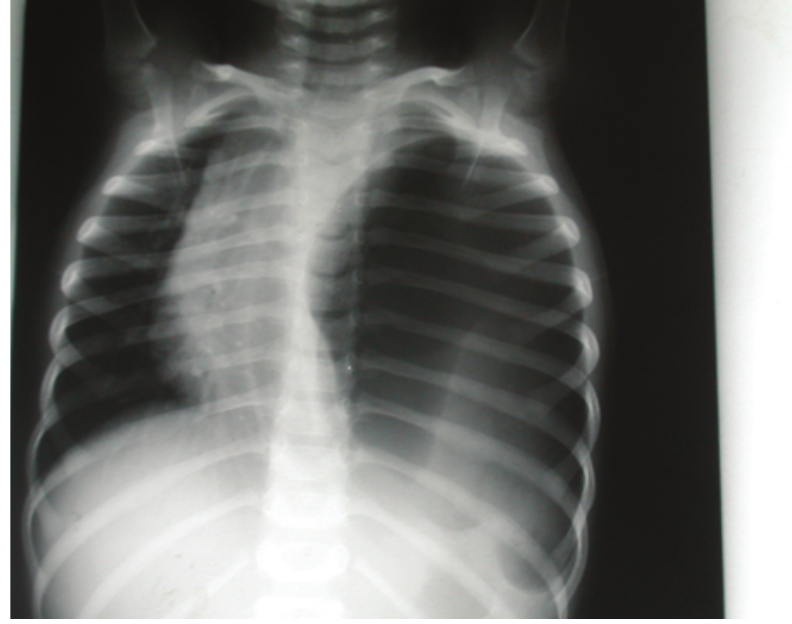
Figure 1: CXR on presentation before operation.